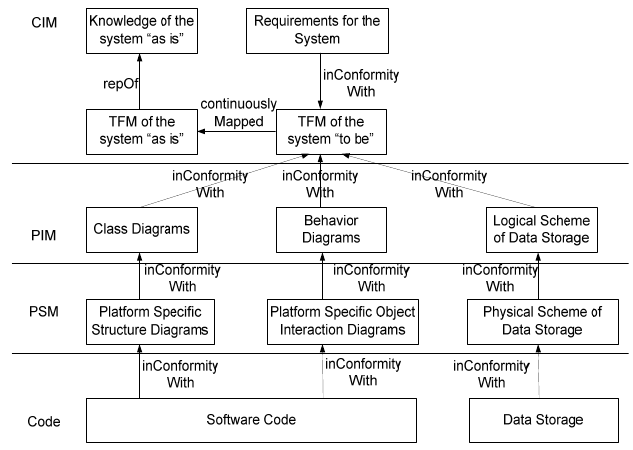
Fig. 2. Continuous mapping between two topological functioning models. Fig. 3. Conformity among models in MDA